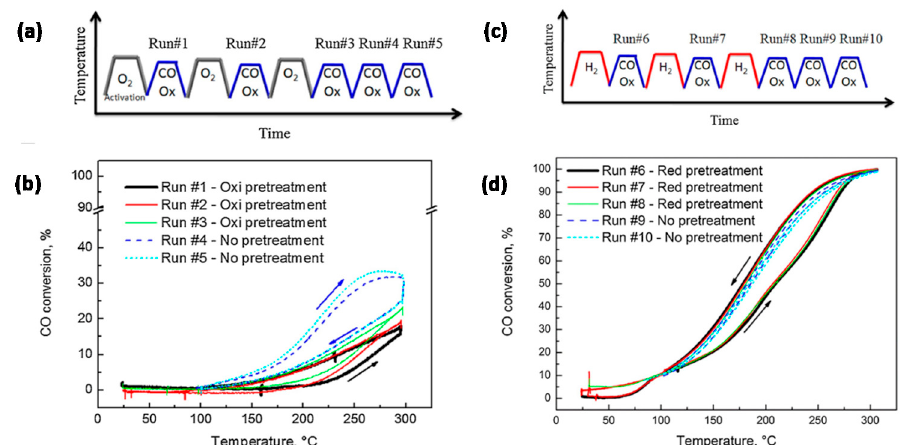
Figure 6. ( a ) Oxidation cycles coupled with CO oxidation tests applied to Au 0.75 Cu 0.25 /SiO 2 . ( b ) CO conversion results for the test protocol represented in ( a ). ( c ) Reduction cycles coupled with CO oxidation tests applied to Au 0.75 Cu 0.25 /SiO 2 . ( d ) CO conversion results for the test protocol represented in ( c ). Reaction conditions for ( b ) and ( d ): 1% CO ( V / V ), 6% O 2 ( V / V ), He balance, GHSV = 3,000,000 Ncc/min (g of (Au + Cu)). Reprinted with permission from Ref. [106]. Copyright 2017 Elsevier.